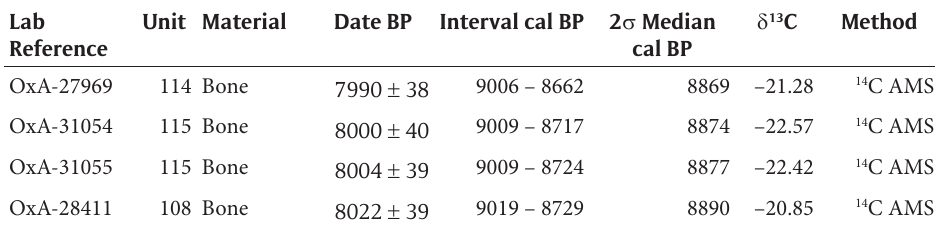
Table 1: Radiocarbon dates from stratigraphic units 108, 114 and 115 at El Mazo (dates from unit 115 come from the same bone sample). Dates were calibrated using IntCal13 calibra- tion curve (calibration program Oxcal 4.2, Reimer et al.